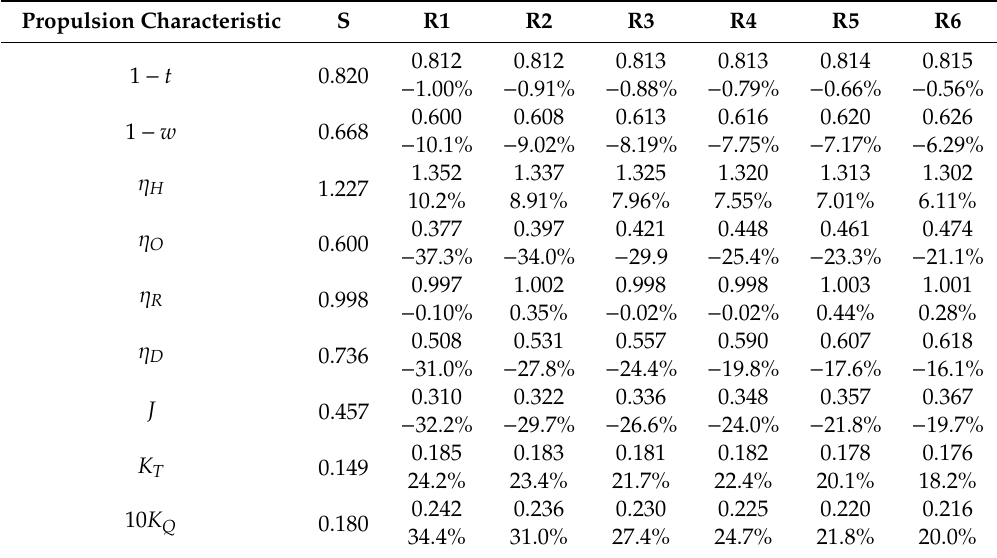
Table 15. The obtained impact of hard fouling on the propulsion characteristics for KVLCC2. Propulsion